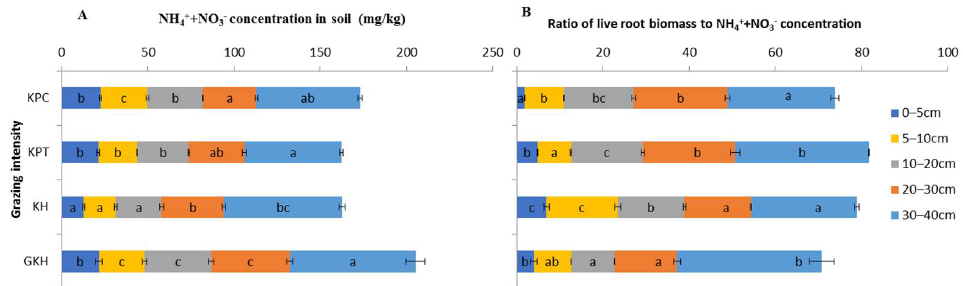
Figure 9. Total concentration and ratio of soil ammonium (NH 4+ -N) to nitrate (NO 3– -N) in the plant community at different grazing intensities: GKH (3.75 ± 0.75 sheep/ha), KH (7.25 ± 0.25 270 sheep/ha), KPT (8.50 ± 0.35 sheep/ha), and KPC (11.75 ± 0.95 sheep/ha). Notations: different letters indicate significant differences between pastures ( α = 0.05). A is the total concentration of “NH 4+ -N + NO 3- -N” in different soil layers; B is the ratio of root biomass to “NH 4+ -N + NO 3 − -N”